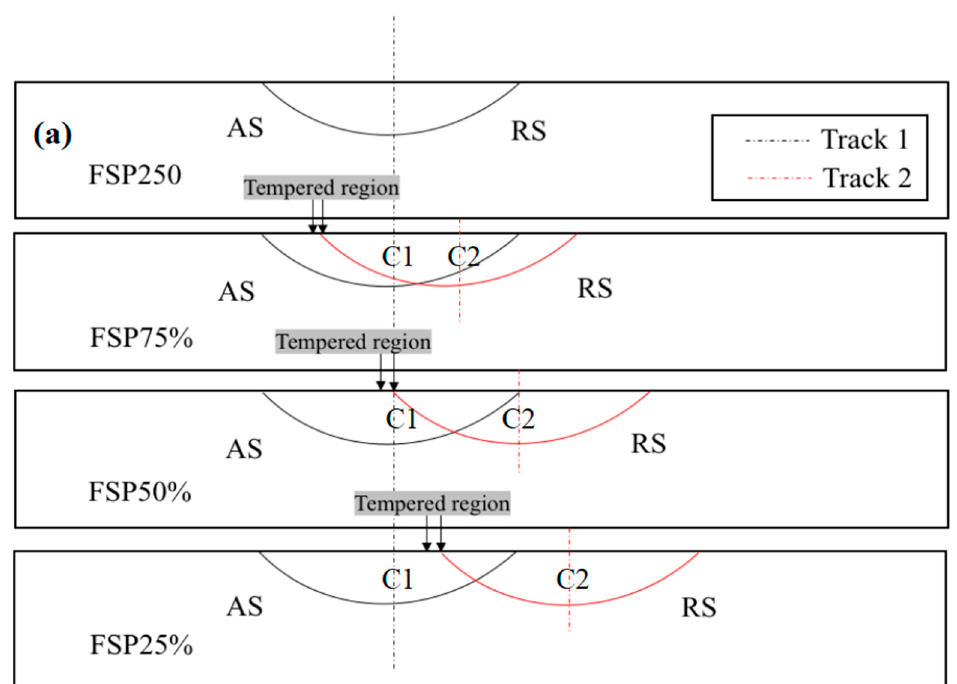
Figure 7. Schematic of changes in crystal structure of martensite during tempering (BCT: body- centered tetragonal; BCC: body-centered